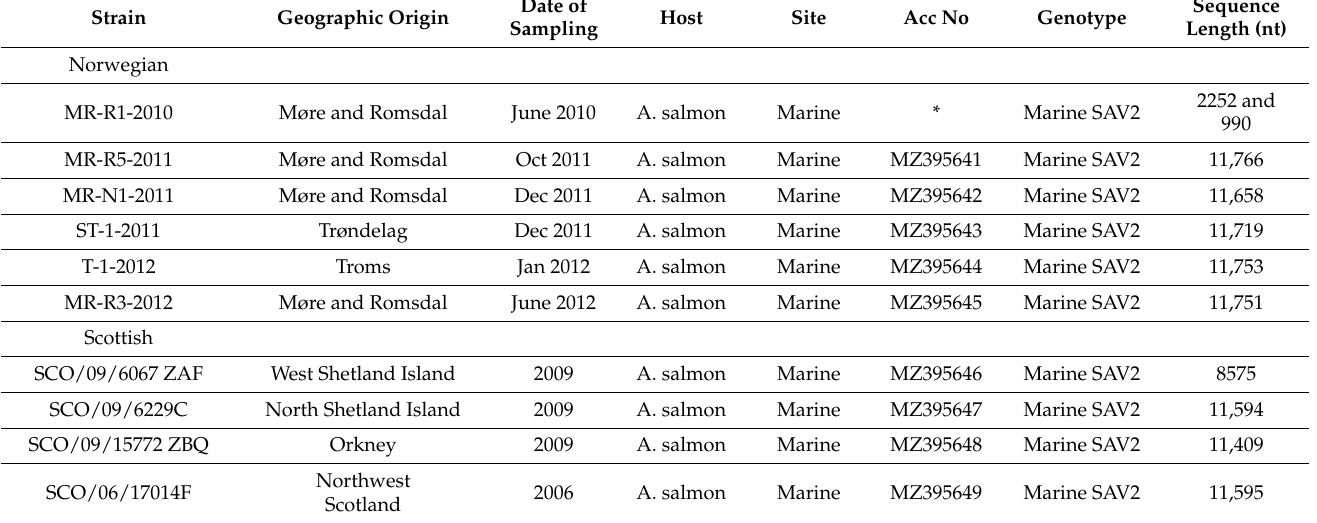
Table 1. Geographical origin and date of sampling of the SAV2 strains. All viruses originated from marine production sites stocked with Atlantic salmon, except SCO/09/18948/12225, which originated from rainbow trout at a freshwater facility. Sequences from the strain MR-R1-2010 were obtained directly from the heart tissue; remaining viruses were cell culture isolates. The sequence length of each strain achieved in this study is also given. * Dataset S1 Supplementary Material.